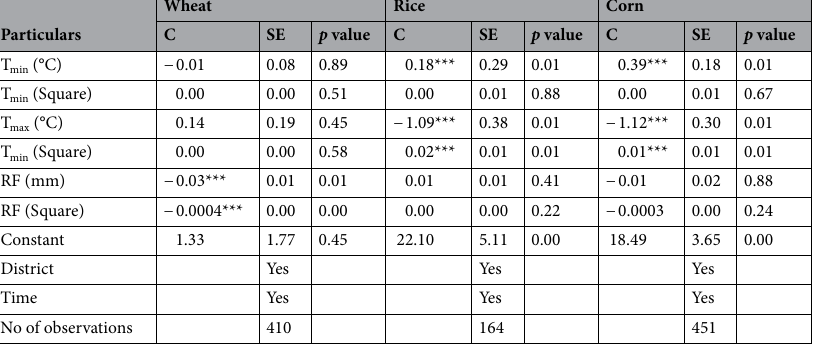
Table 5. Regression estimates of the impact of temperature and rainfall on the yield of major cereal crops in the SE-US, 1980–2020. ***Denote significance at the 1% level; C, SE, and RF represent regression coefficient, standard error, and rainfall,